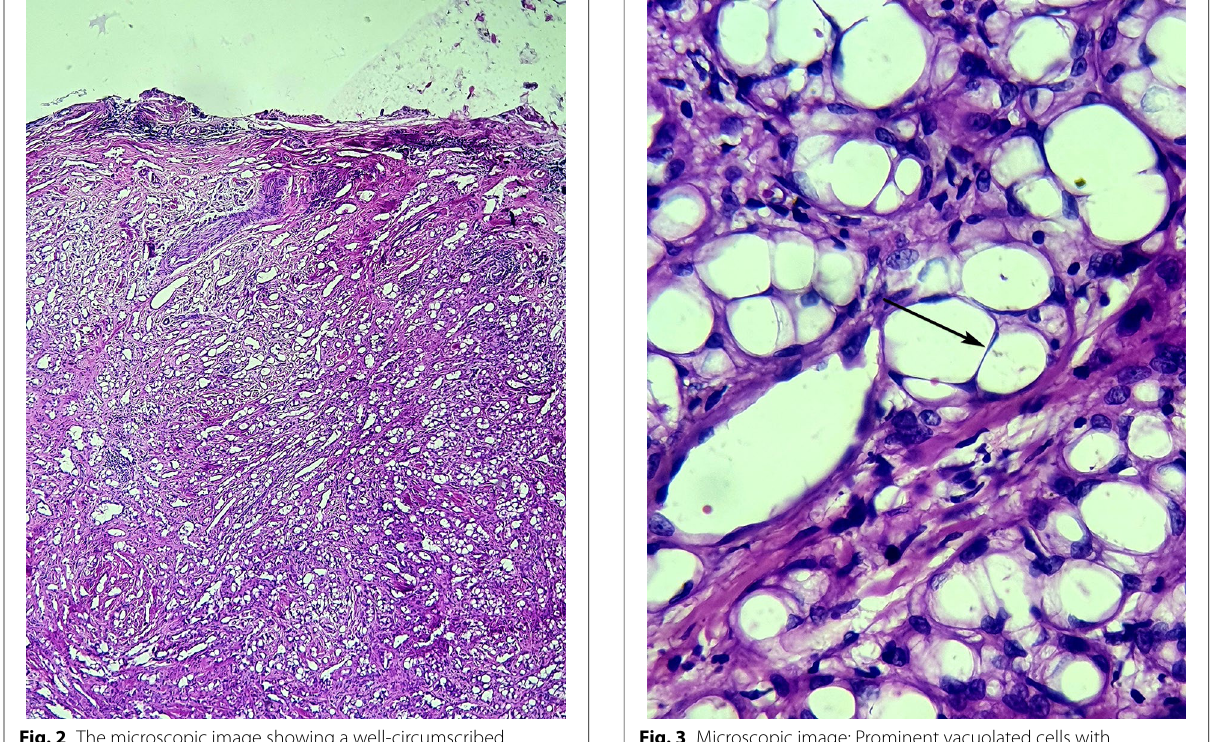
Fig. 2 The microscopic image showing a well-circumscribed tumor with microcystic and trabecular architecture made of small interconnected tubules and cysts (hematoxylin and eosin stain